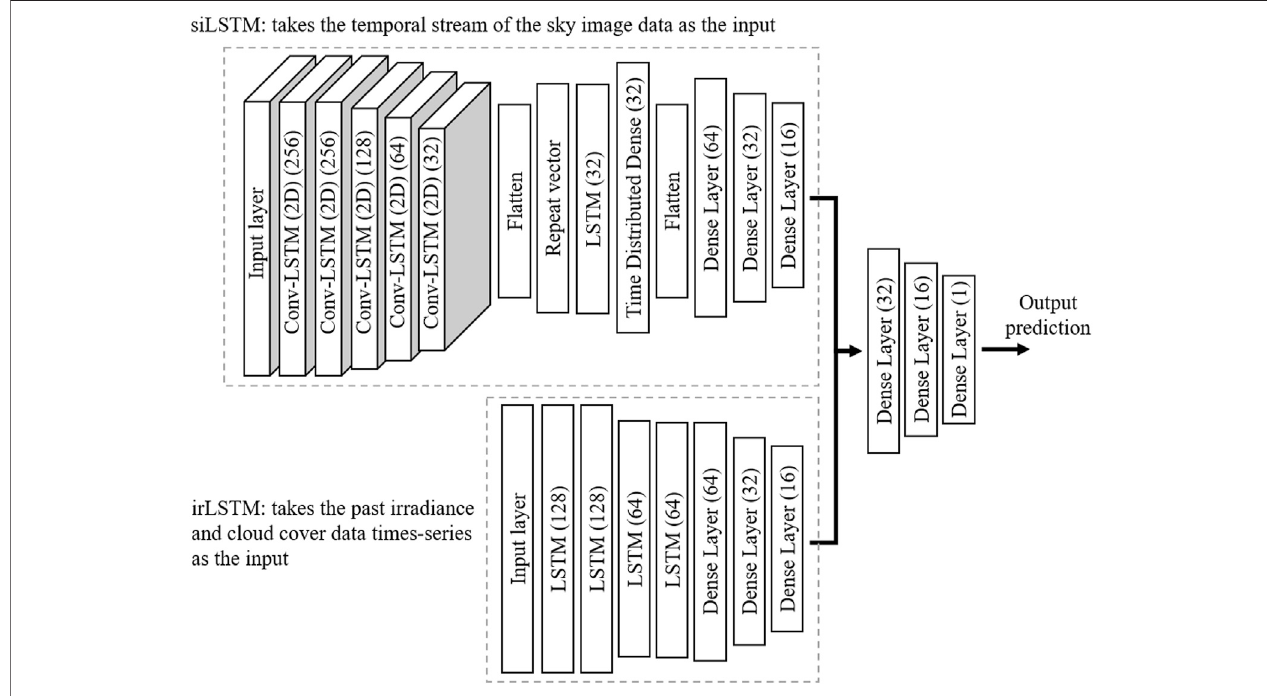
FIGURE 9 | Model architecture of the multimodal LSTM networks.